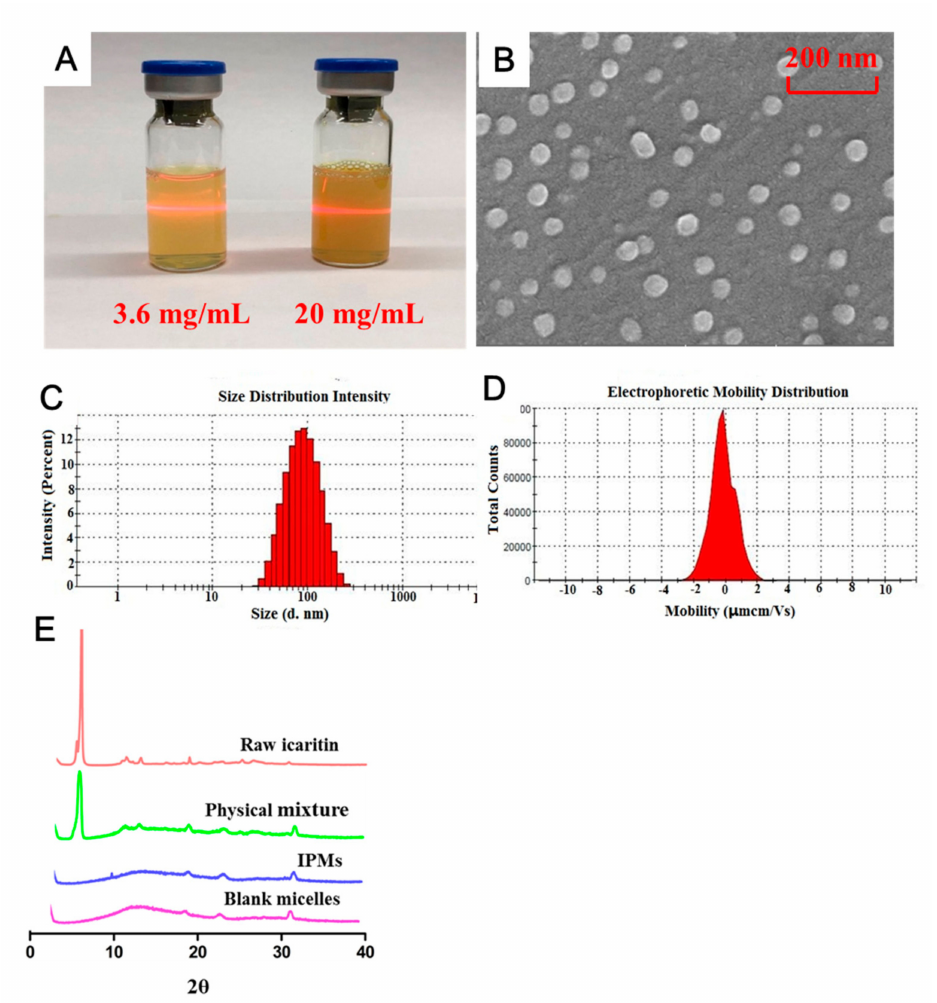
Figure 3. ( A ) Photographs of IPMs solutions containing 3.6 mg/mL icaritin (left) and 20 mg/mL icaritin (right). ( B ) The SEM images of IPMs. ( C ) Size distribution and ( D ) Zeta potential of IPMs. ( E ) The X-ray powder diffractogram of raw icaritin, blank micelles, physical mixture of icaritin and polymers, and IPMs. IPMs, icaritin-loaded polymeric micelles; SEM, scanning electron